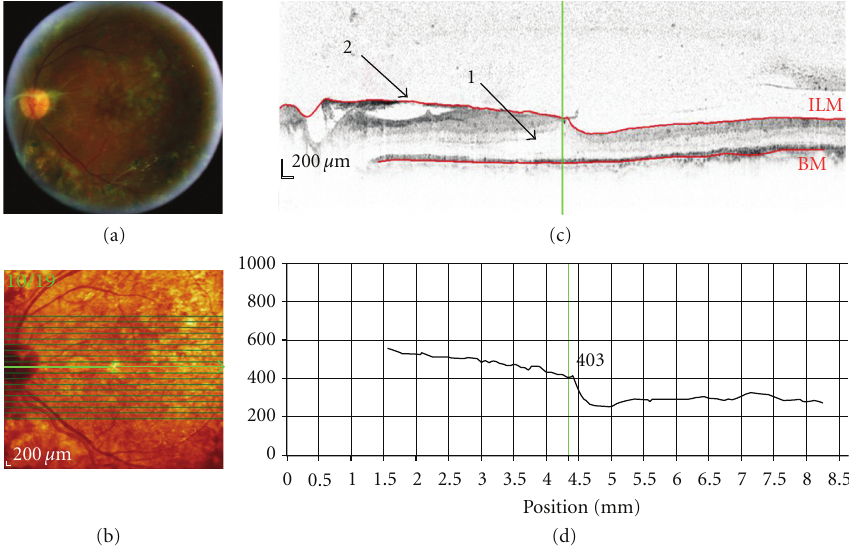
Figure 3: SD-OCT of a patient with proliferative diabetic retinopathy and clinically significant diabetic macular edema (DME) (OS). Scan parameters: infrared scan angle 30 ◦ ; OCT scan angle 30 ◦ ; pattern size 30 ◦ × 15 ◦ , 19 sections (240 µ m between B-scans). (a) The conventional fundus camera image showed clinically significant DME, fibrous tissue/epiretinal membrane temporal to the optic nerve head (ONH) extending towards the fovea and inferior to the fovea, neovascularisation at the ONH and also at the inferior macula and laser scars in the macula area and outside of the major retinal arcades. (b) SD-OCT en-face image centered on the fovea. The green arrow shows the position of the scan line used to generate the cross-sectional retinal OCT image (i.e., (c)). (c) The cross-sectional retinal image revealed cystoid spaces temporal to the ONH and extending close to the fovea in the outer retina (arrow “1”). The fibrous tissue/epiretinalmembrane can also be seen, located between the ONH and fovea ( arrow “2”). (d) The cross-sectional retinal thickness profile revealed increased retinal thickness especially nasally to the fovea.